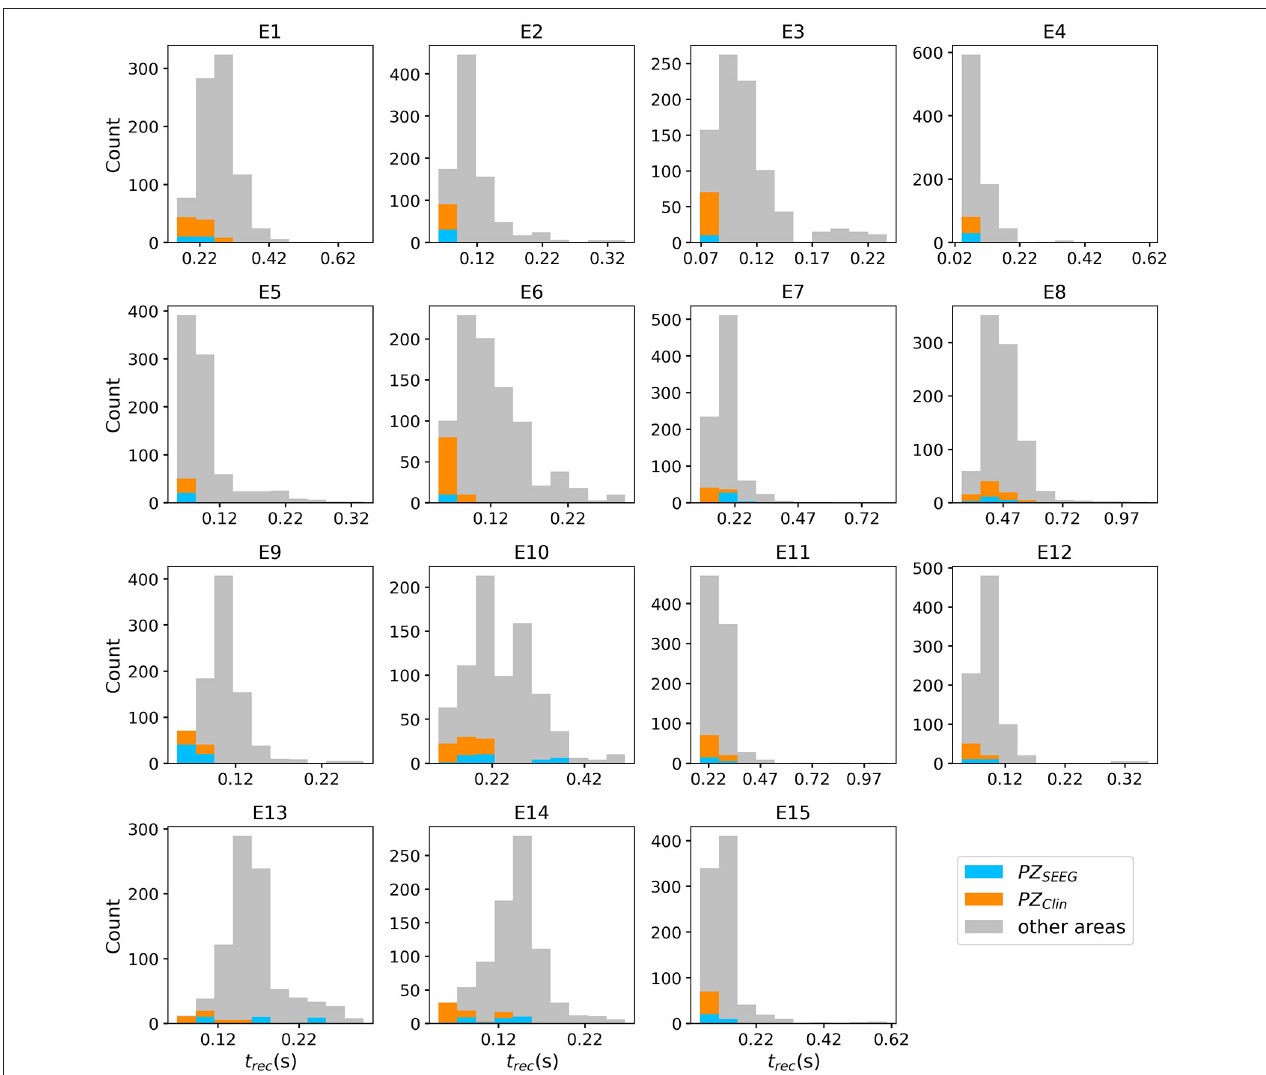
FIGURE 11 | Histograms of recruitment times for all patients with epileptic. For each patient (identified by his/her number), the recruitment times of all the brain areas are collected, once the EZ is stimulated. If several areas were identified in the EZ, they are all stimulated simultaneously. The EZ is chosen according to the presurgical evaluation (as shown in Supplementary Table 4 ) and vary from one patient to the other. Parameters as in Figure 10 except for